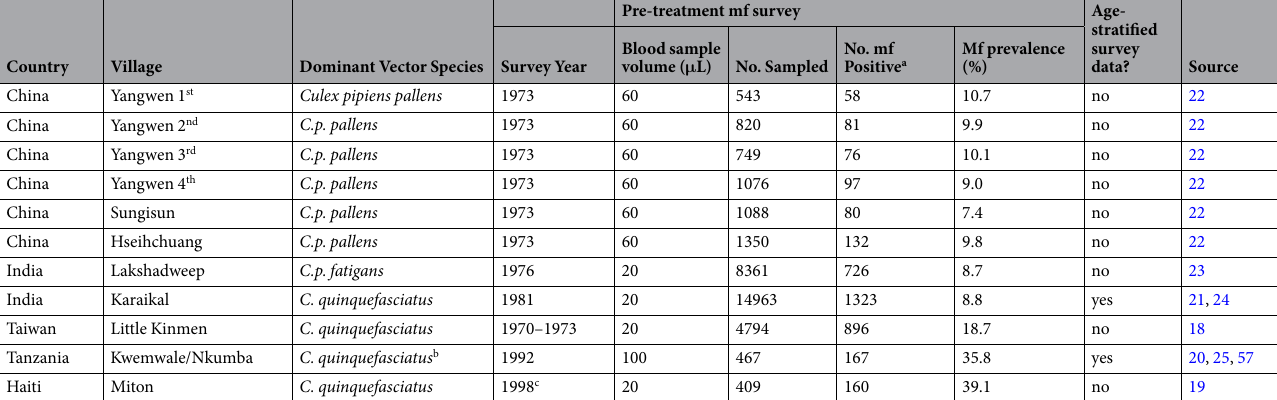
Table 2. Baseline survey data for the 11 study sites. a The number of positive cases is corrected for blood sample volume using a correction factor of 1.15 for 100 μ L and 60 μ L samples and 1.95 for 20 μ L samples 30 . b There is some uncertainty regarding the dominant vector species in Kwemwale/Nkumba, Tanzania. In addition to C. quinquefasciatus , both Anopheles gambaie s.l . and An.funestus have been cited as vectors responsible for transmission around Tanga and Muheza 57, 58 . c The survey year was given by reference 59 .